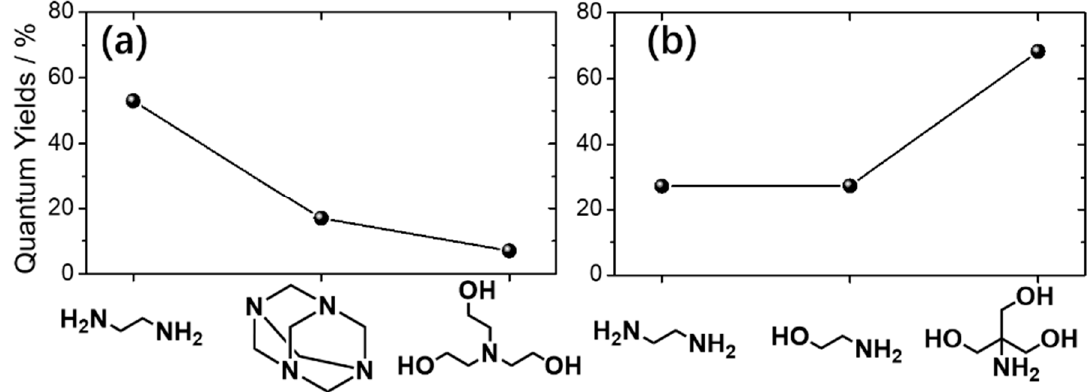
Figure 8. The quantum yields of CDs synthesized from CA and different nitrogen sources. The data in ( a , b ) are organized according to Ref. [73] and Ref. [74], respectively.